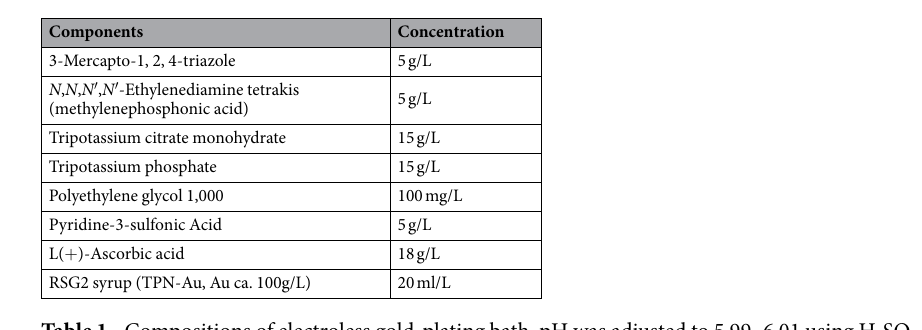
Table 1. Compositions of electroless gold-plating bath. pH was adjusted to 5.99–6.01 using H 2 SO 4 and